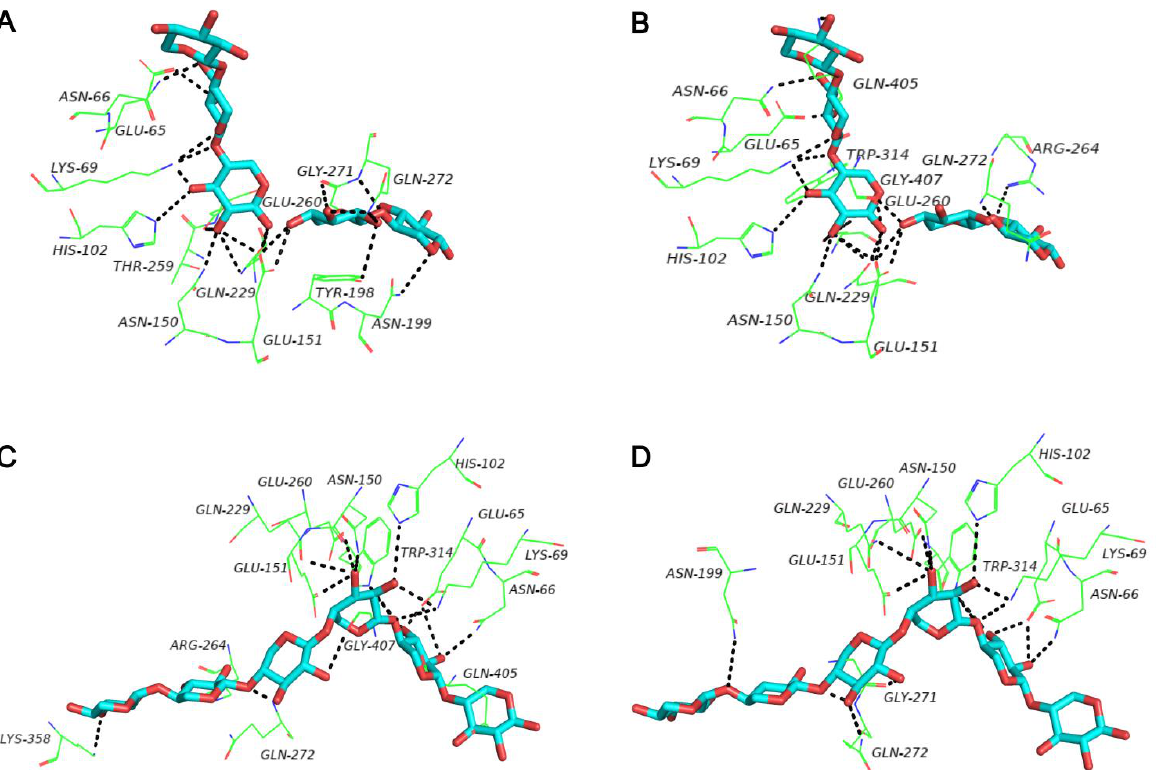
Figure 4. Detailed interaction networks in the active site of XynA with X5 ( A ), XynA-Tr with X5 ( B ), XynA with X6 ( C ), and XynA-Tr with X6 ( D ) after superimposition. The residues of XynA and XynA-Tr that interacted with X5 or X6 are shown as green lines, X5 and X6 are shown with blue sticks. Black dashed lines represent the hydrogen bonds.